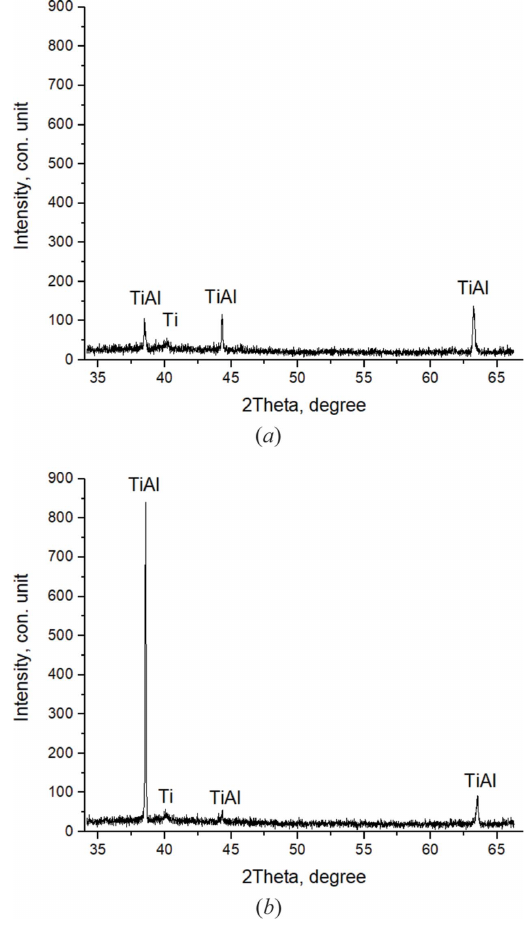
Figure 15 Diffractograms of the 40th ( T = 1392.9 (cid:3) C) ( a ) and the 41st ( T = 1384.9 (cid:3) C) ( b ) shots.